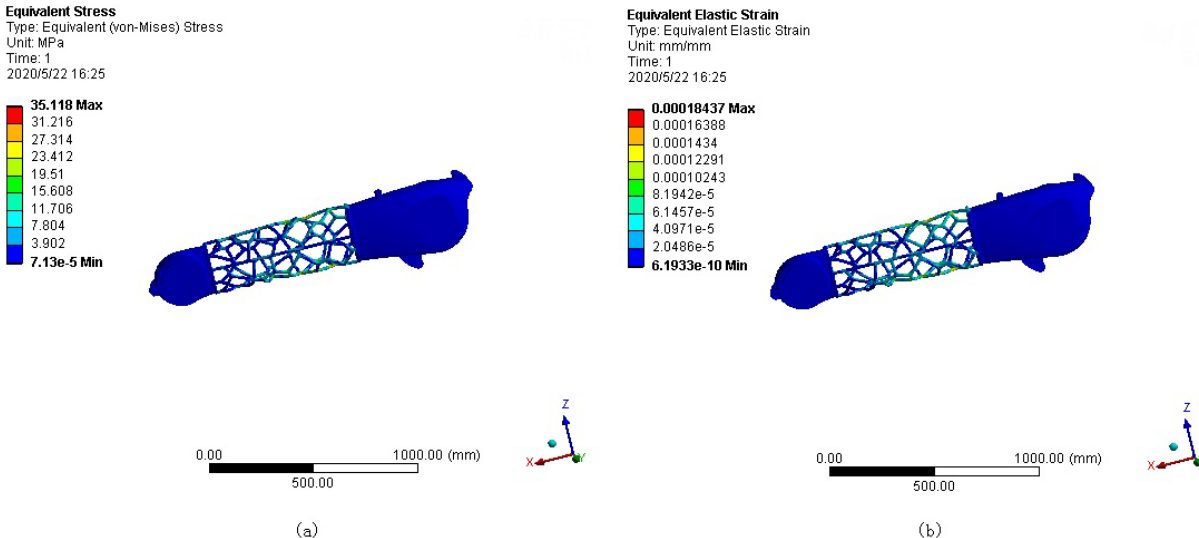
Figure 17. Static analysis of the optimized manipulator arm model: (a) random point equivalent stress cloud diagram; (b) random point equivalent strain cloud diagram.